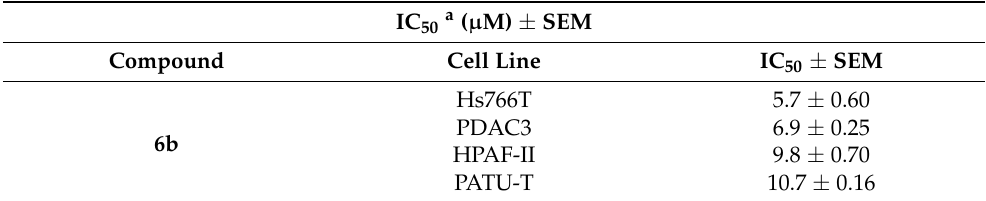
Table 2. IC 50s of 6b against Hs766T, HPAF-II, PDAC3, and PATU-T